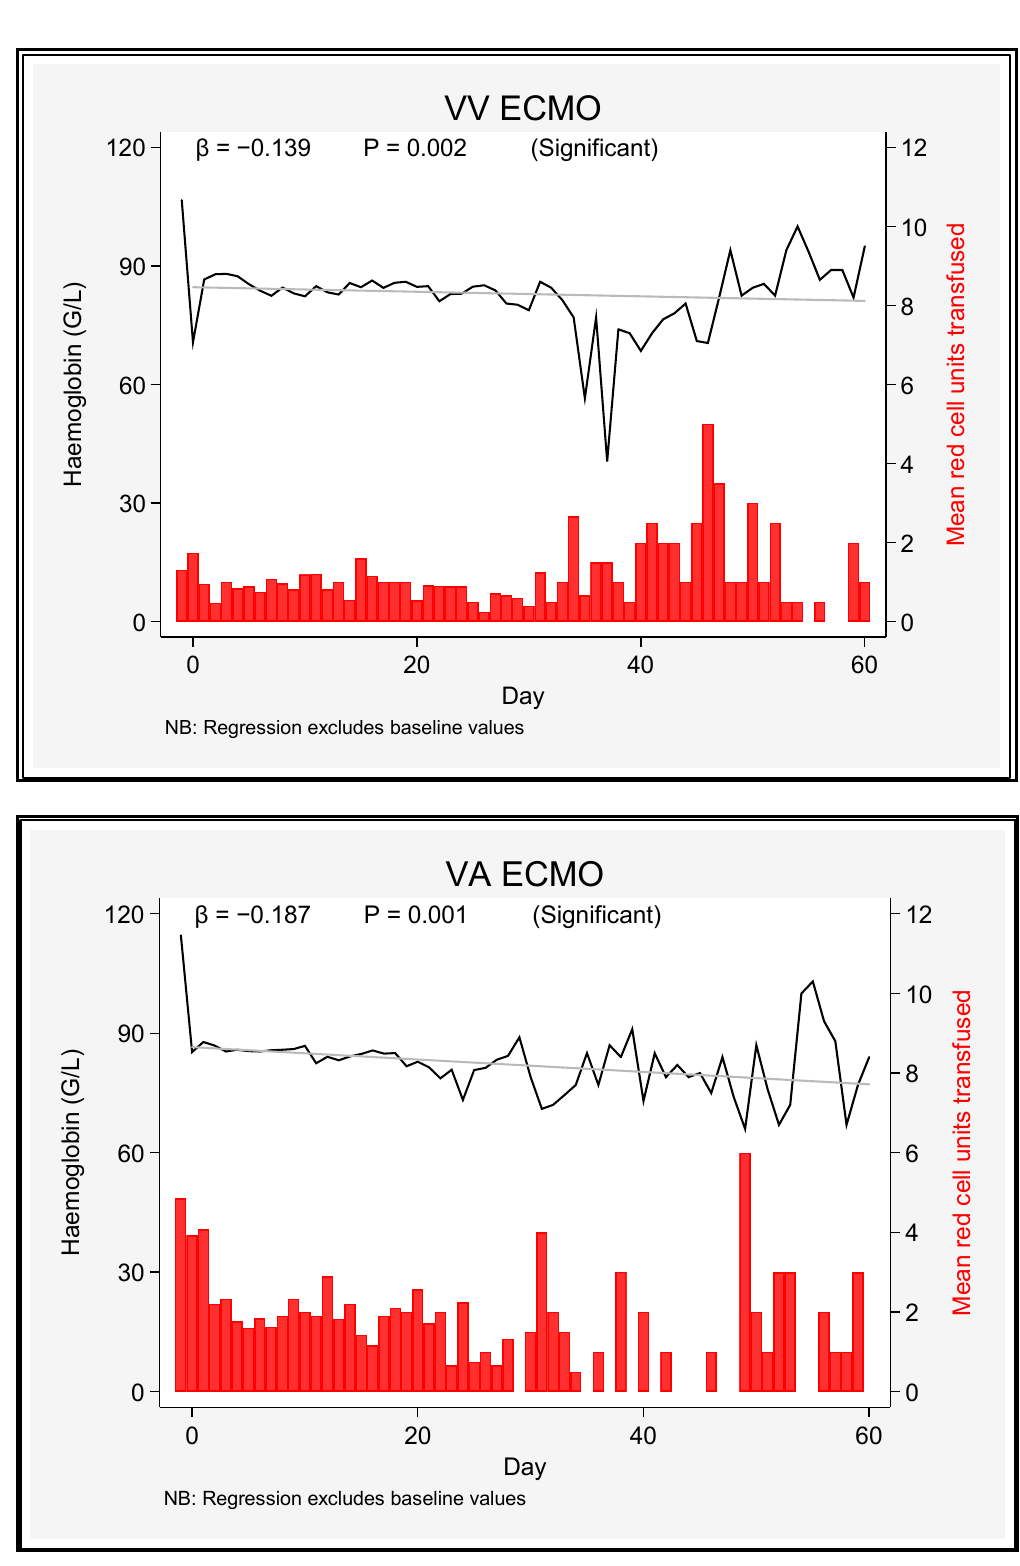
Figure 1. Haemoglobin level and packed red blood cell transfusion requirements in VV and VA ECMO patients over 60 days.